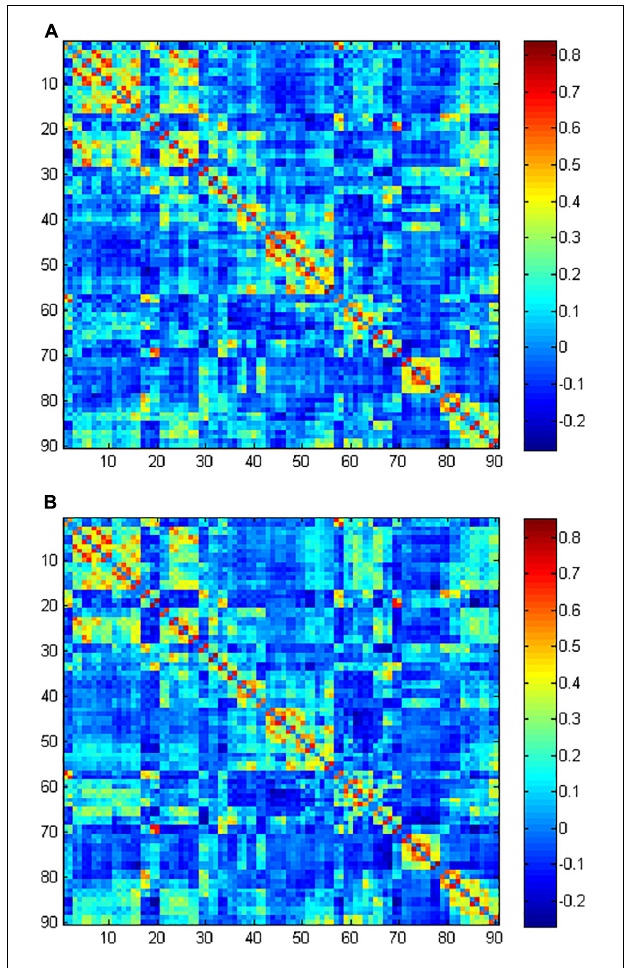
FIGURE 1 | The group-averaged functional connectivity matrix of normal-hearing (NH) group (A) and sensorineural hearing loss (SNHL) group (B)